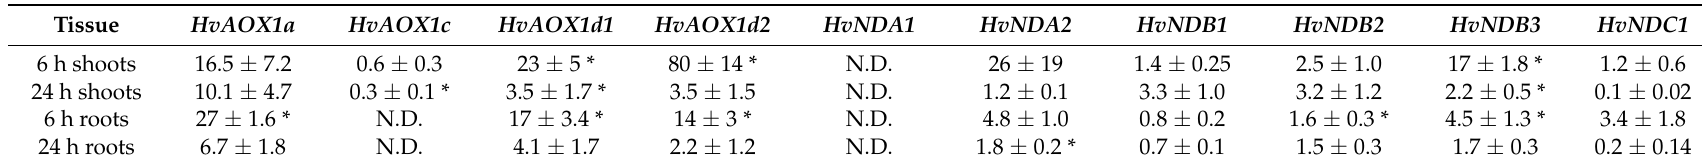
Table 3. Expression of barley AP genes under chemical stress. Fourteen-day-old barley seedlings (cv. Golden Promise) were exposed to 5 mM potassium cyanide for 6 and 24 h. Transcript amount was determined using qRT-PCR. Data were normalized with Housekeeping genes, Actin , Ubiquitin and Pdf (Protein phosphatase) and shown as mean fold change ± SE of four biological replicates relative to the control at each point set at 1.00. ND refers to being at the limit of detection for the assay used. After KCN treatment, HvNDA1 did increase but to a very low level, and the absence of expression in the control tissue made this difficult to express as a fold change. * denotes significantly different ( p < 0.01) from the